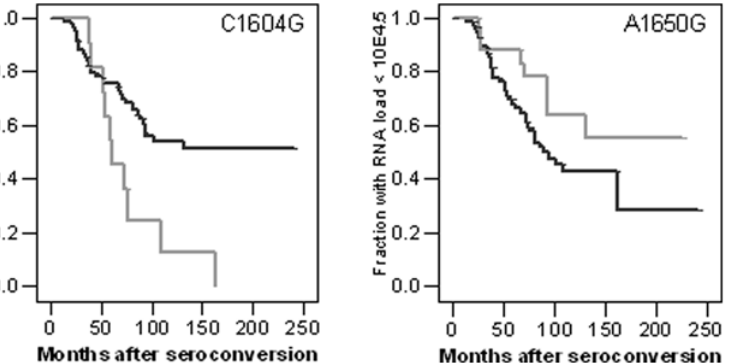
Figure 1. Survival analysis for C1604G and A1650G in DU of the ACS. Kaplan Meier analysis for time in months from seroconversion to viral RNA load above 10 4.5 copies per ml plasma in DU of the ACS based on the C1604G genotype (left panel) or A1650G genotype (right panel). Black lines indicate individuals homozygous for the major allele (left panel: 1604CC; right panel: 1650AA); Gray lines indicate individuals heterozygous for the minor allele (left panel: 1604CG; right panel: 1650AG).